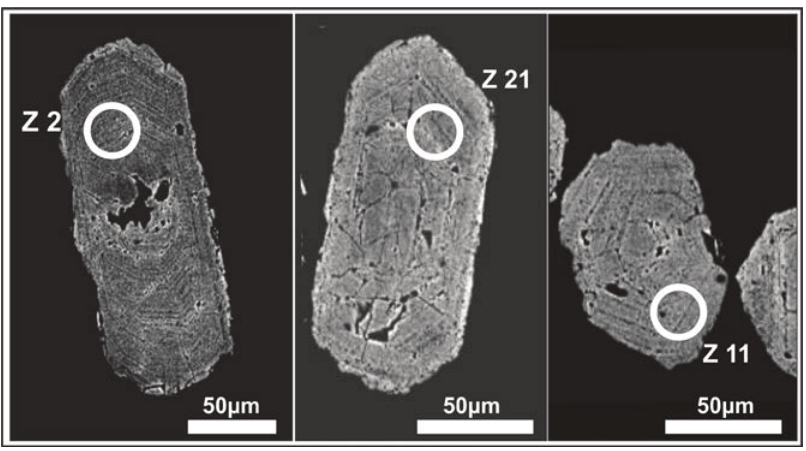
Figure 12 - Backscattered electron images of representative augen gneiss zircons, emphasizing growth zonation, xenomorphic inclusions, fractures and corroded rims (sample AR-44C).